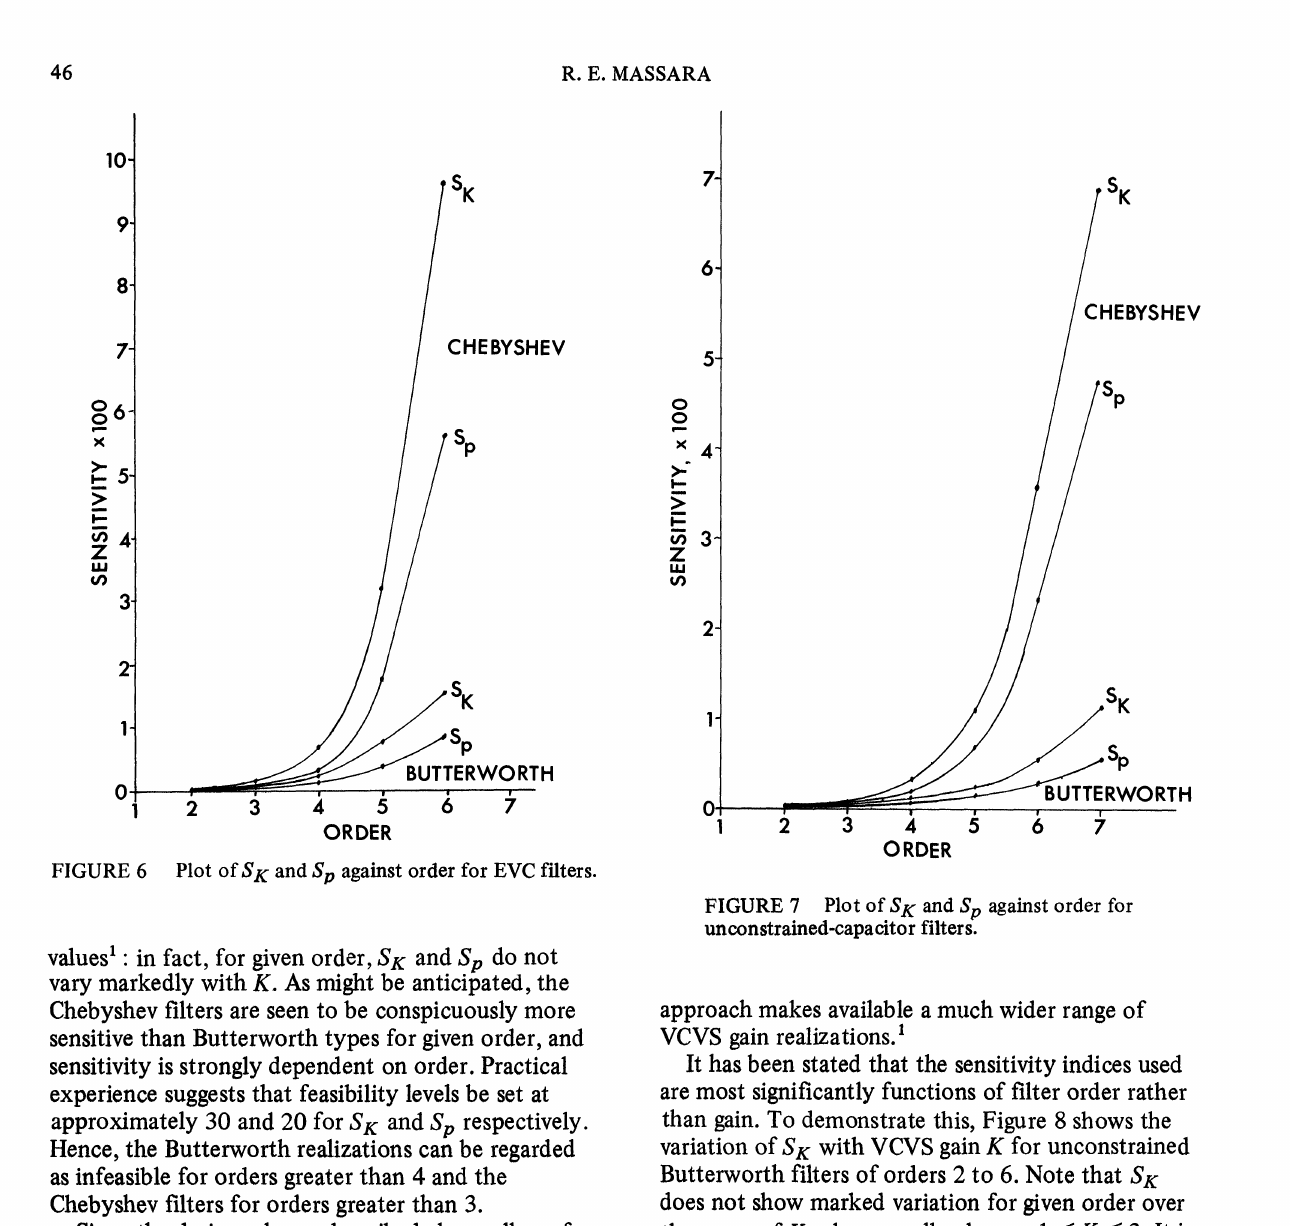
FIGURE 7 Plot of S K and So against order for unconstrained-capacitor